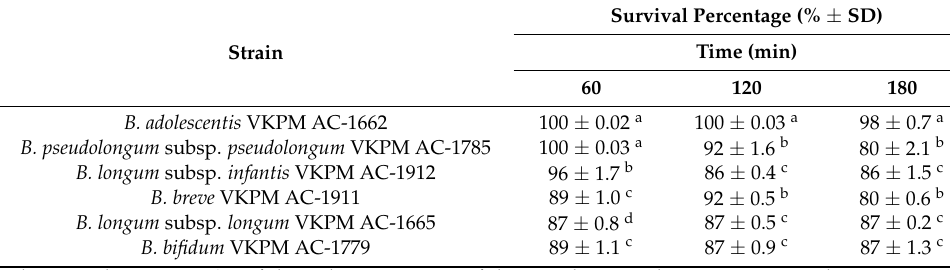
Survival Percentage (% ± SD) Time